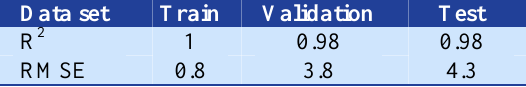
Table 4. Statistical characteristics of artificial neural networks (ANN) model of